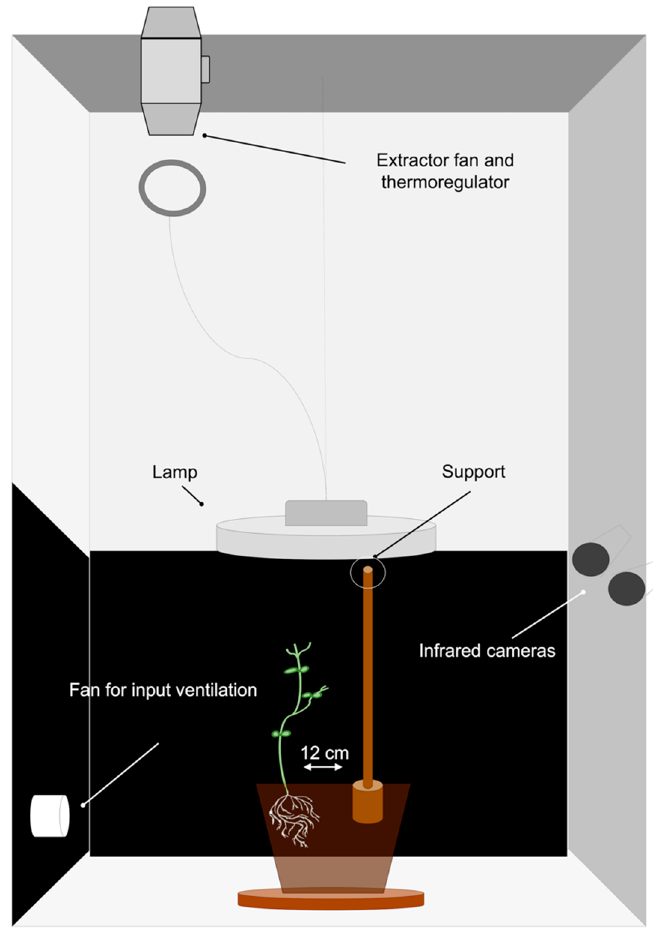
Figure 2. Graphical representation of the experimental set up. The representation illustrates the ‘Thick-Below’